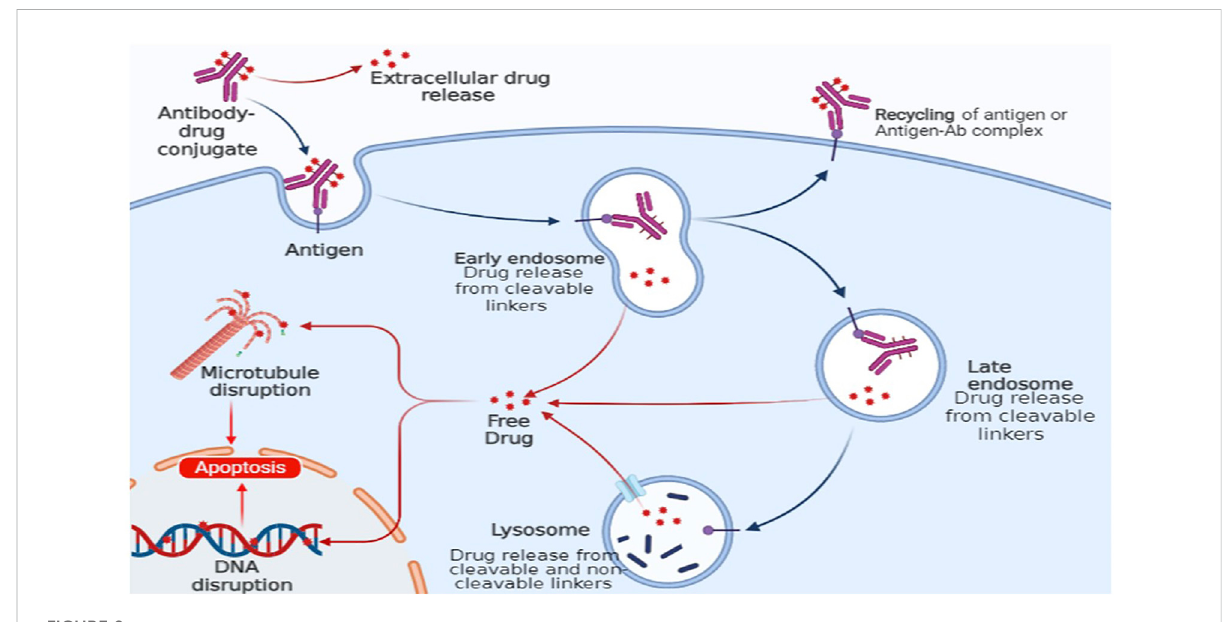
FIGURE 9 The general mechanism of action of an antibody-drug conjugate